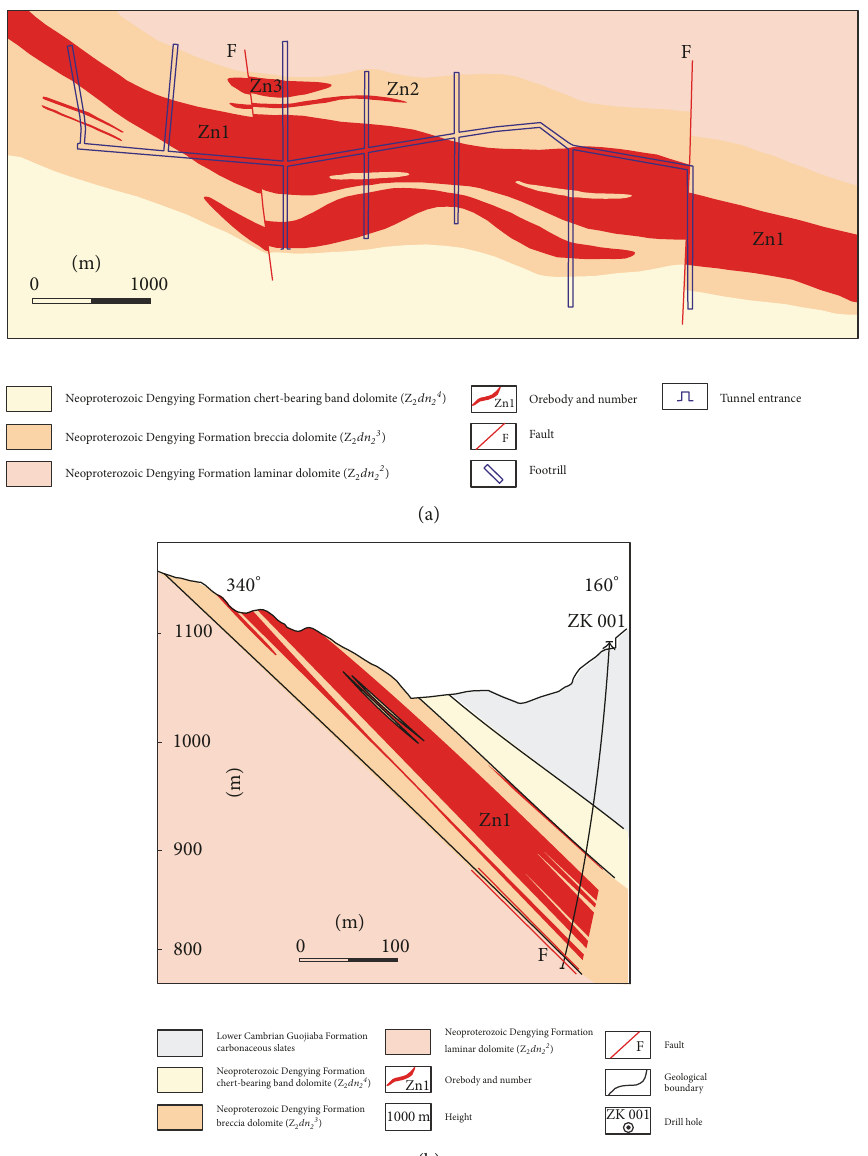
Figure 3: (a) Representative simplified geologic map showing the occurrence and morphology of major orebody Zn1 at 1030 m above sea level in the Nanmushu Zn-Pb deposit (after Li et al., 2007 [9]). (b) Cross-section of the Nanmushu Zn-Pb deposit (modified from Hou et al., 2007